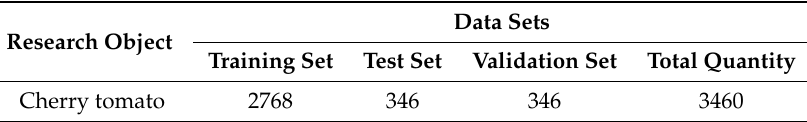
Table 1. Quantity of sample data